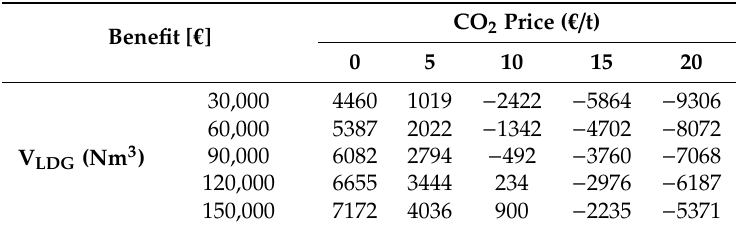
Table 9. Sensitivity analysis of the CO 2 and gasholder level.